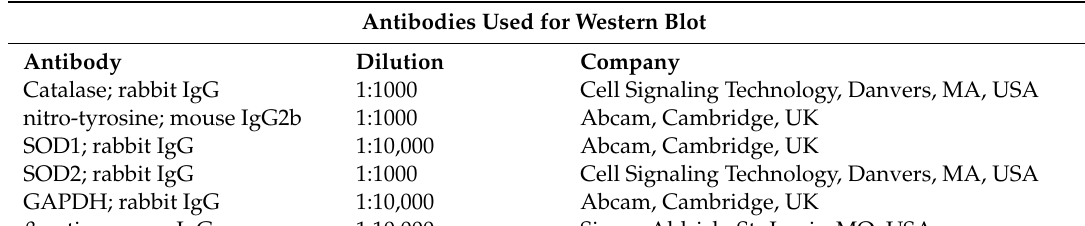
Table 1. List of antibodies, used dilutions and primer used for